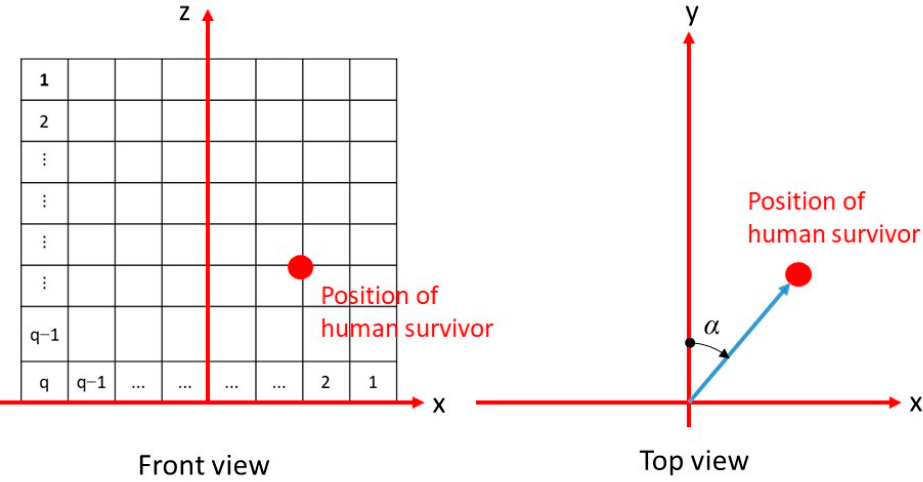
Figure 4. Geometry for detecting the position of a human survivor.